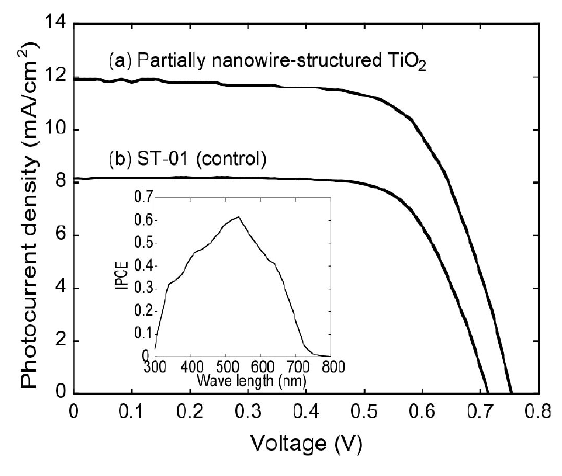
Fig. 5 Photocurrent-voltage characteristics of DSCs prepared by using (a) partially nanowire-structured TiO ( η = 6.01 %), and (b) ST-01 powder ( η = 4.13 %). Insert: 2 IPCE spectrum for